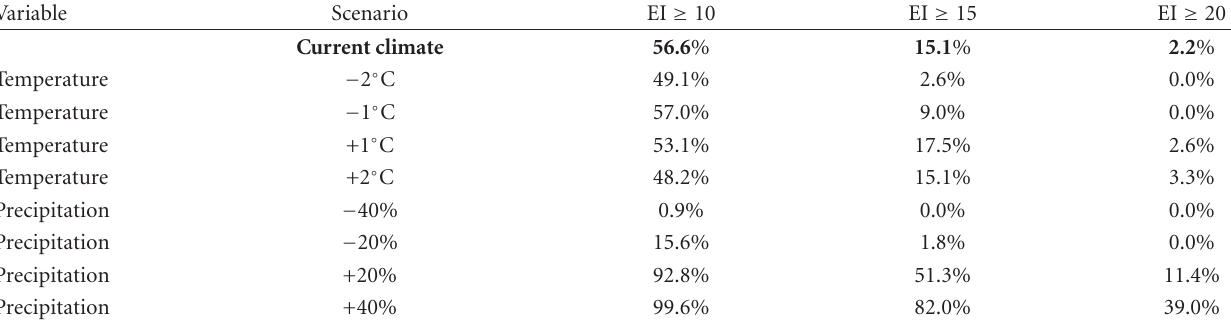
Table 4: E ff ect of changes in temperature and precipitation from current climate on Ecoclimatic Indices (EIs) for Sitona lineatus in southern and central Alberta ( n = 456 grid cells). Values are % of total area. The values are expressed as a percentage of total geographic area in this